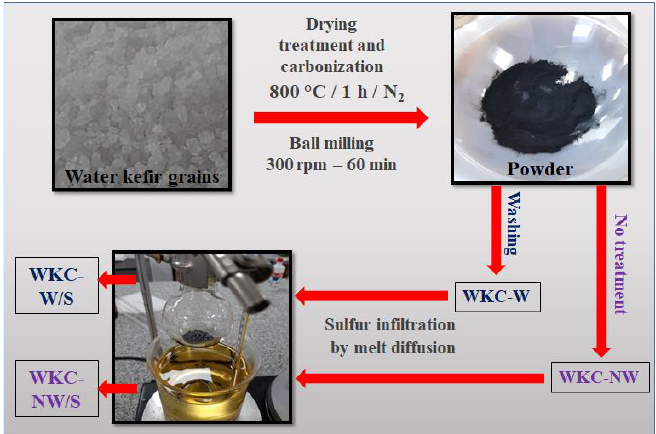
Figure 2. Scheme of the synthesis procedure for the WKC-NC/S and WKC-W/S composites.